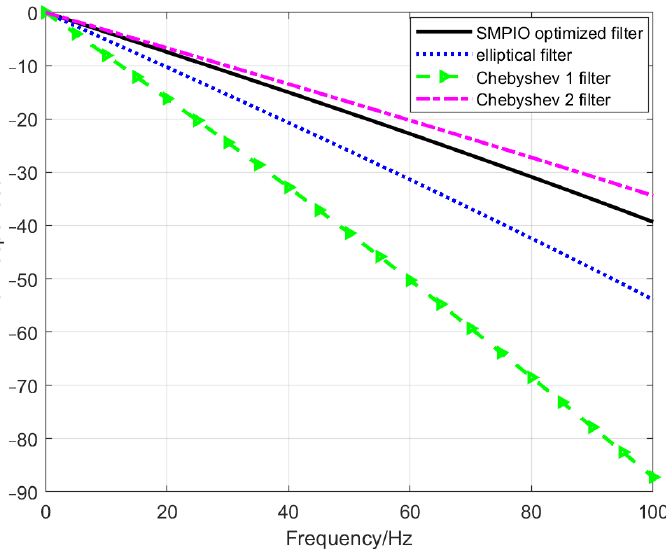
Figure 12. Phase response comparison of various types of filters (0 Hz~100 Hz, m = 6, amplitude and phase optimized). Table 4. Various types of IIR filter parameters ( ω s = 300 Hz, ω p = 400 Hz, m = 6, amplitude and phase optimized).